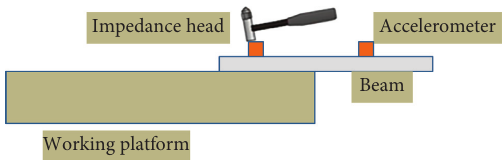
Figure 12: KRIGING model modification test function of cross-point excitation. By modifying the transfer function between subsystems, the overall model is modified.